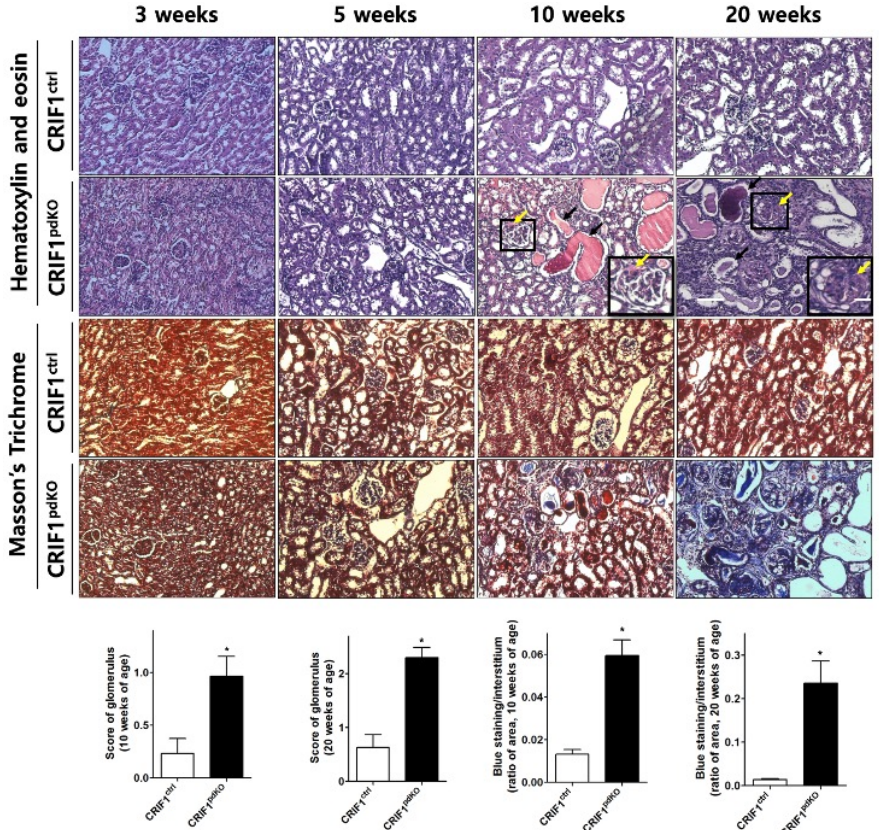
Figure 2. Podocyte-specific CRIF1 deficiency leads to glomerular sclerosis and tubulointerstitial fibrosis in mice. Hematoxylin and eosin staining (upper panels) and Masson’s Trichrome staining (lower panels) of the renal cortex in CRIF1 pdKO and CRIF1 ctrl mice at 3, 5, 10, and 20 weeks of age. Large black boxes show higher magnifications of the small black boxed areas in the larger panels. Scale bars, 20 μ m (large panels) and 7 μ m (small panels). The yellow and black arrows in the panels showing sections from 10- and 20-week-old CRIF1 pdKO mice indicate the occurrence of glomerular sclerosis and proteinaceous casts, respectively. The glomerular sclerosis scores and interstitial fibrosis areas in kidneys from 10- and 20-week-old CRIF1 ctrl and CRIF1 pdKO mice. Data are represented as the mean ± SD. * p < 0.05 by Student’s t -tests.